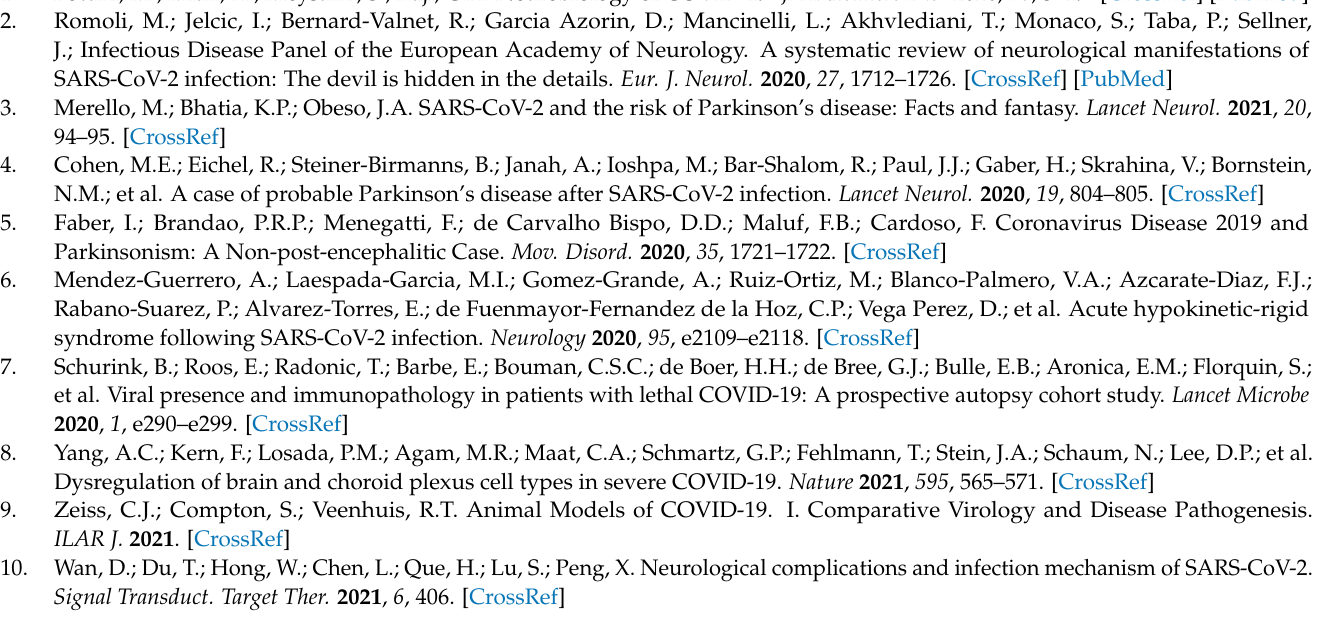
antigen staining. Figure S2: Examples of a GFAP staining for astrocytes from the dorsal midbrain area of an (A) infected rhesus macaque and (B) uninfected control monkey. Activation of astrocytes was observed neither in the SARS-CoV-2-infected monkeys nor the